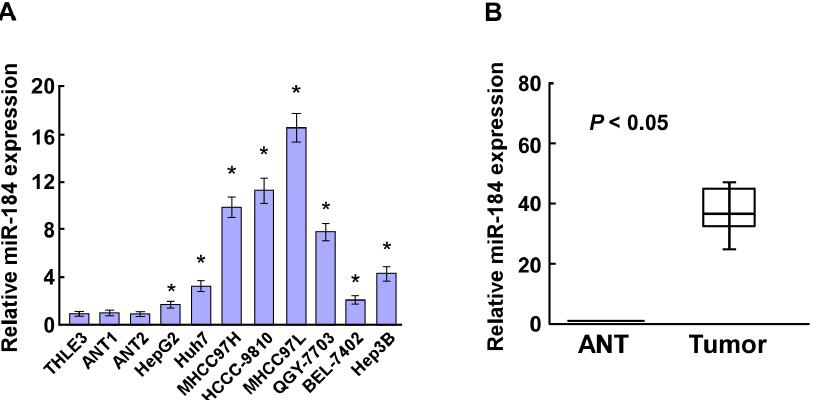
Figure 1. Expression of miR-184 is elevated in HCC. A . Real-time PCR analysis of miR-184 expression in hepatocellular carcinoma cell lines (Hep3B, BEL-7402, MHCC97H, HCCC-9810, MHCC97L, Huh7, QGY-7703 and HepG2), compared with normal liver epithelial THLE3 cells and two noncancerous hepatic tissues (ANT1 and ANT2). B . The expression of miR-184 was examined in eight paired cancerous tissues (T) and their adjacent noncancerous hepatic tissues (ANT), showed in a boxplot. The average miR-184 expression was normalized using U6 expression. Each bar represents the mean 6 SD of three independent experiments. * P , 0.05.